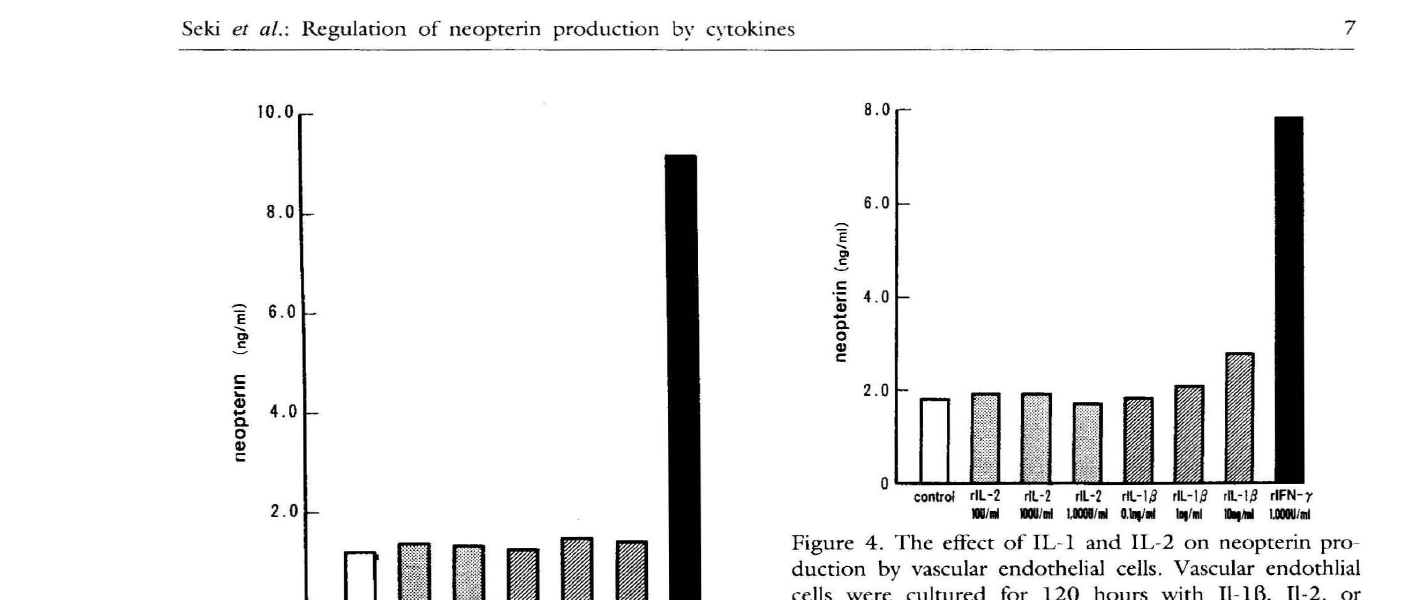
Figure 4. The effect of IL-l and IL-2 on neopterin pro duction by vascular endothelial cells. Vascular endothlial cells were cultured for 120 hours with 11-113, Il-2, or IFN-y. Neopterin in each supernatant was determined us ing RIA.